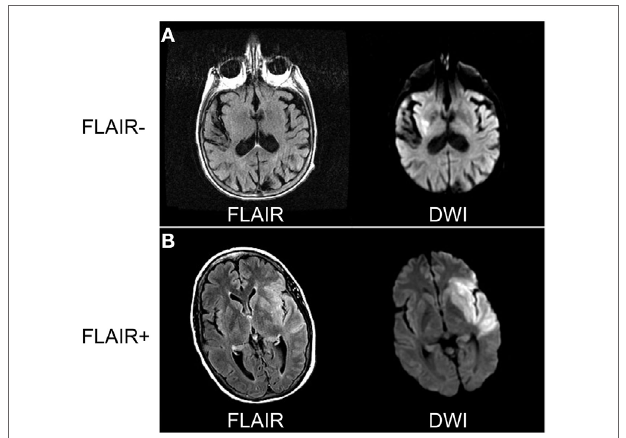
FigURe 2 | Comparing diffusion-weighted imaging (DWI) and FLAIR sequences to determine radiographic time of stroke onset. (A) Eighty-one- year-old woman awoke with dysarthria and right-sided weakness. Magnetic resonance imaging (MRI) performed 8 h from last-known well (LKW) shows signal abnormality in DWI but not FLAIR sequences. (B) Sixty-three-year-old woman developed sudden onset right-sided weakness with confirmed LKW. MRI performed 5 h from LKW shows signal abnormality on both DWI and FLAIR sequences consistent with stroke onset > 4.5 h. Data analysis for figure was created under approval of local ethics